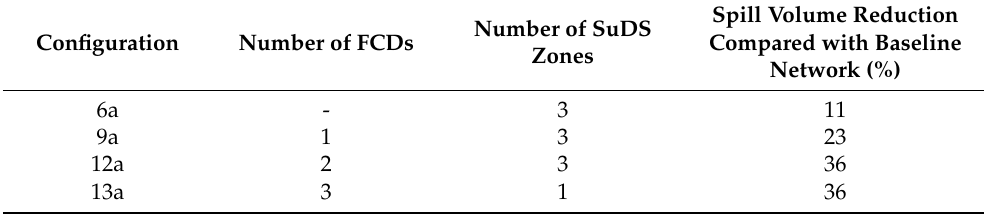
Table 5. Overflow spill volume reduction achieved in the Arendonk catchment model for the 3-year rainfall series based on the numbers and types of intervention measures that were implemented (the overflow spill volume discharged at the regulated CSO in the baseline network was equal to 86,230 m 3 ). Spill Volume Reduction Number of SuDS Configuration Number of FCDs Compared with Baseline Zones Network (%) 6a